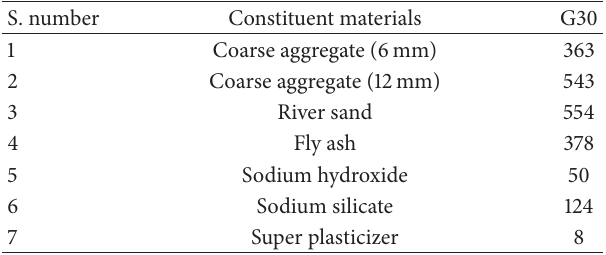
Table 2: Mixture proportions of G30 (quantity in kg per m 3 of concrete